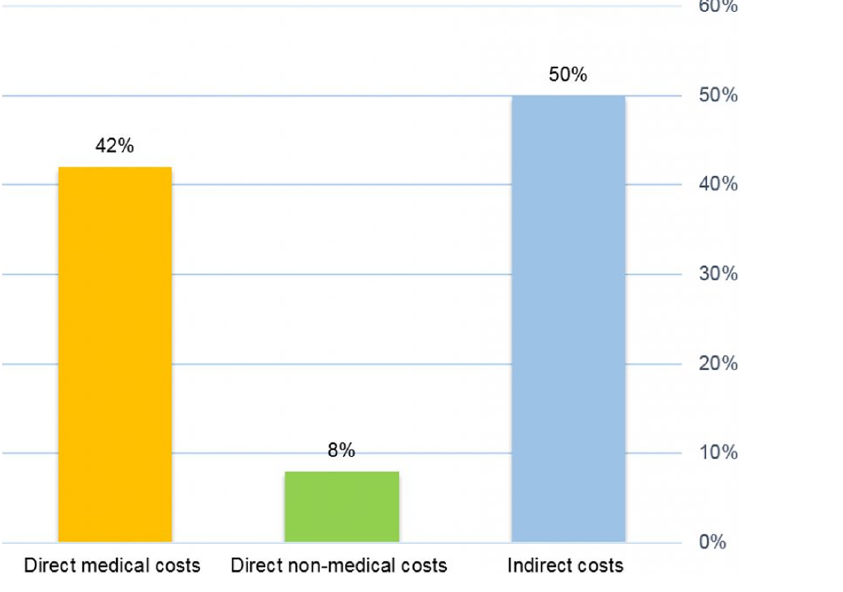
Fig 1. The economic burden of oral cancer in Iran in